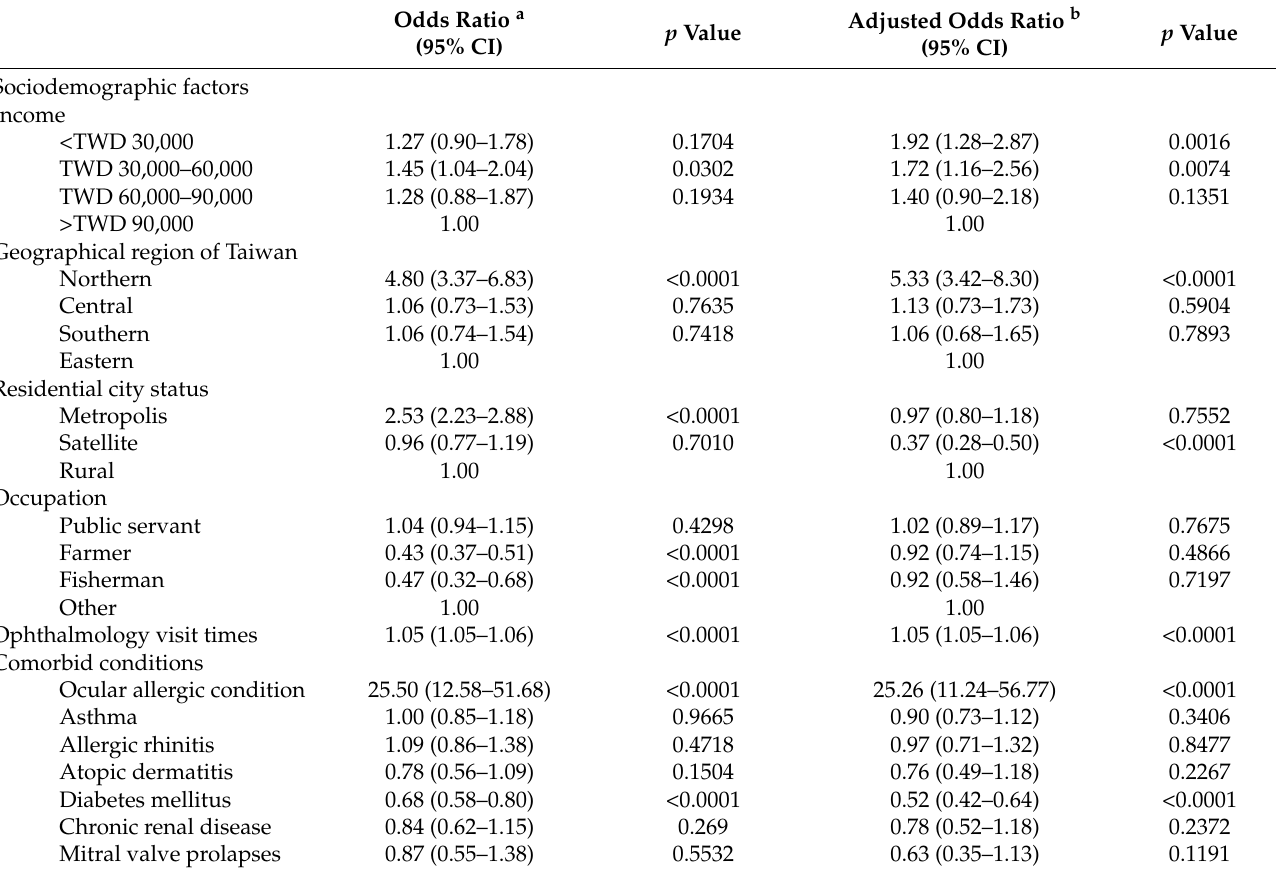
Table 2. Odds ratios and adjusted odds ratios for various sociodemographic factors and comorbid conditions with Fuchs’ endothelial dystrophy. Odds Ratio